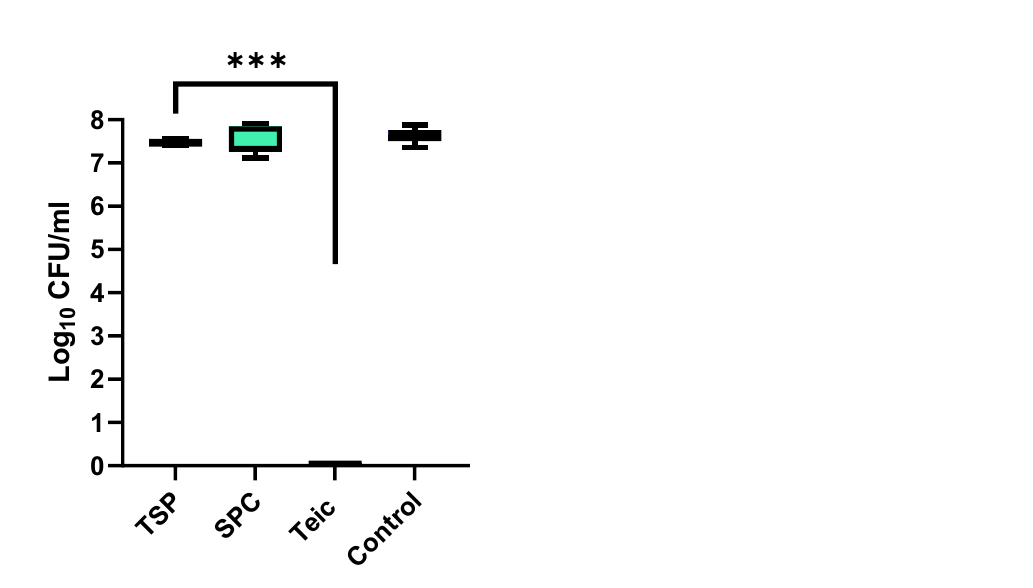
Figure 9. The tripeptide N-Acetyl-L-Lys-D-Ala-D-Ala binds avidly to a teicoplanin stationary phase (TSP). Aliquots (100 mg) of TSP and a silica particle control (SPC) were exposed to 500 µl of the tripeptide (200 µg/ml) prepared in 50 mM HEPES (pH 7.4) and incubated at room temperature for 30 min. After incubation, samples were centrifuged and the supernatants (SN) collected, the pH adjusted to 8.4 and 500 µl treated with 5 µl of genipin (250 mM in DMSO). Samples were left to incubate at 60 °C for 2 h. After incubation, the optical density (OD) of the samples were measured using a microplate reader. The OD for the tripeptide control and SPC supernatants were similar indicating no tripeptide binding to the SPC. In contrast the supernatant recovered from the TSP had a significantly reduced OD (*** p < 0.0001) when compared to the tripeptide control, indicating good binding of the tripeptide with the TSP. All data (mean ± SD; N = 9) represent pooled triplicate runs from 3 independent experiments.